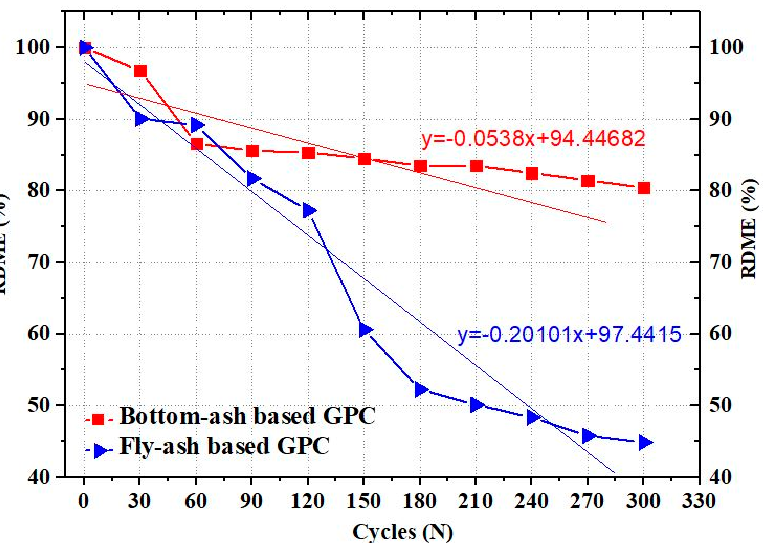
Figure 6. Average Relative Dynamic Modulus of Elasticity (RDME) reduction of fly-ash based GPC and bottom-ash based GPC vs. No. of cycles.